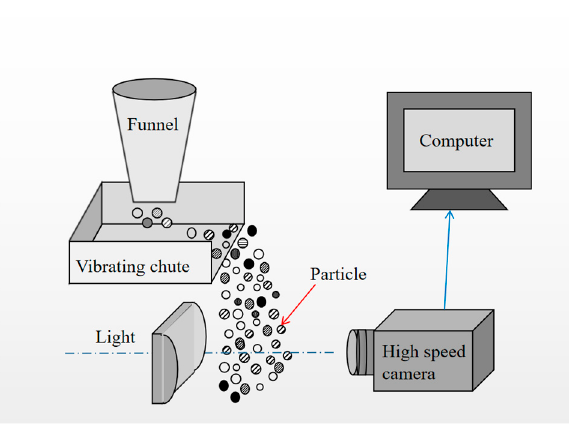
Figure 2. Schematic of the dynamic image particle analysis system.